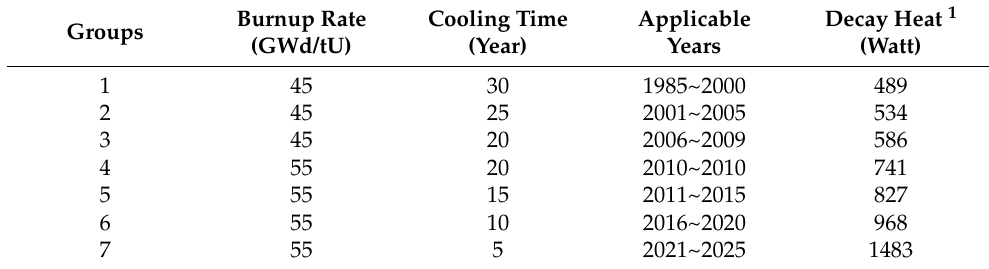
Table 7. Representative spent nuclear fuel groups of Kori units